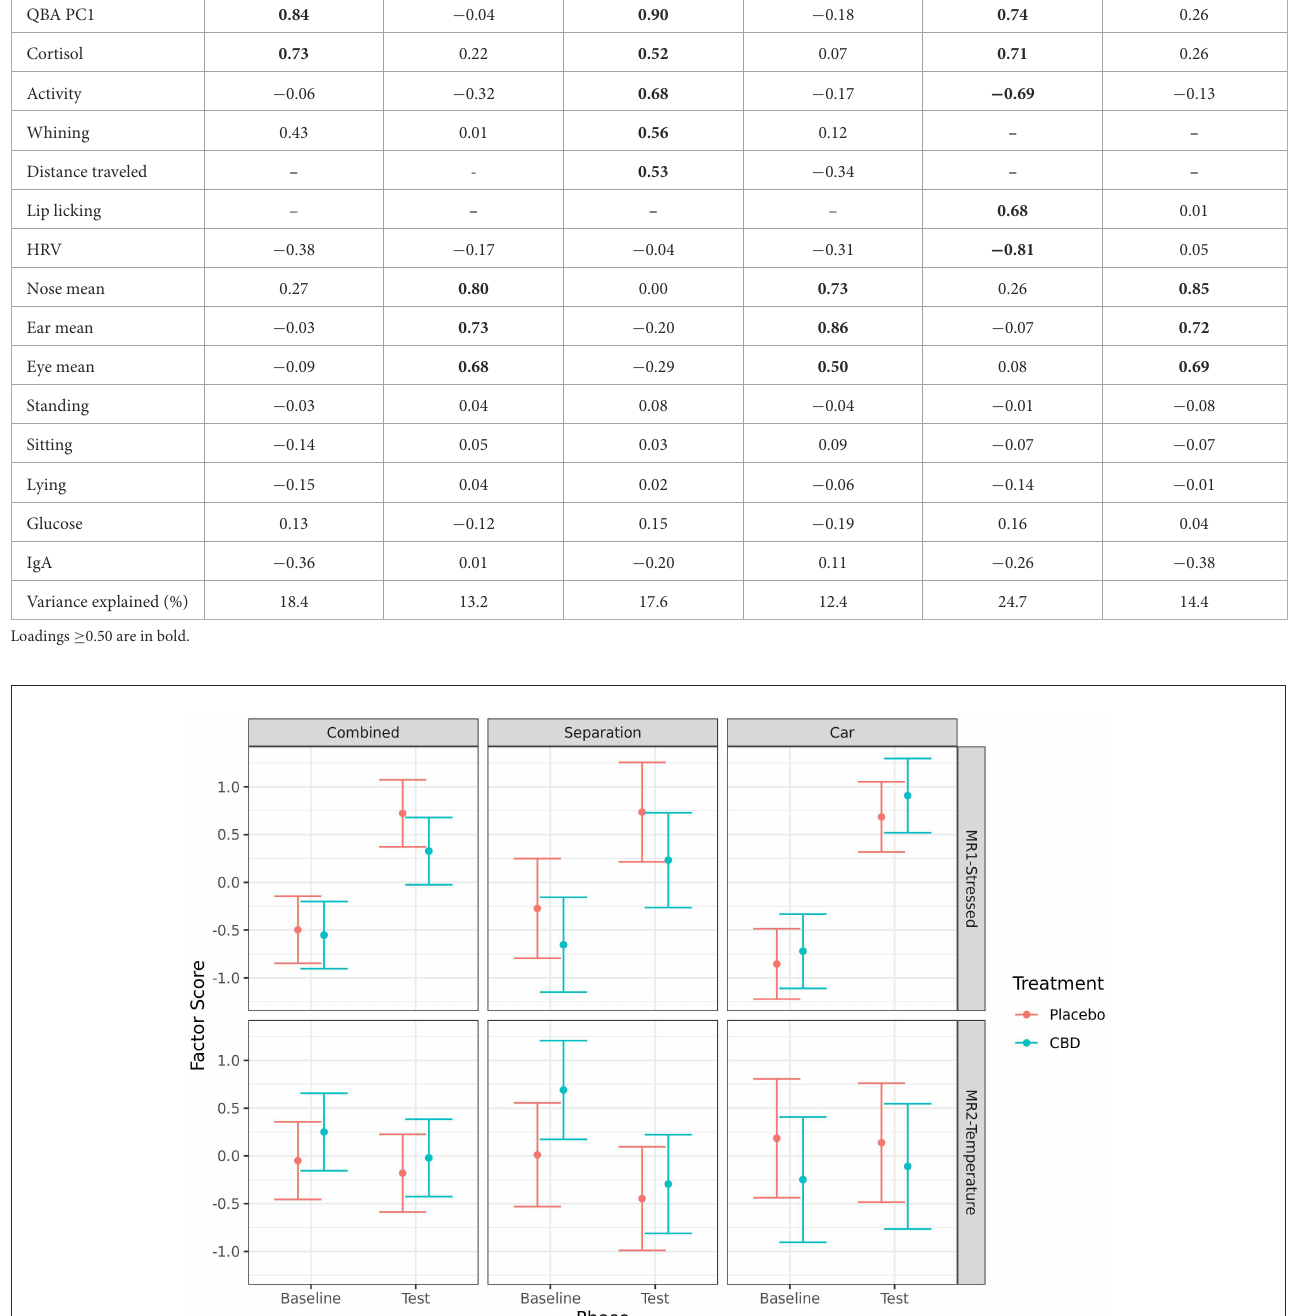
TABLE 4 Factors extracted by the factor analysis of all measures when analyzed with both stress tests combined, or with separation and car tests separately. Combined Separation Car Measure MR1 stress MR2 temp MR1 stress MR2 temp MR1 stress MR2 temp